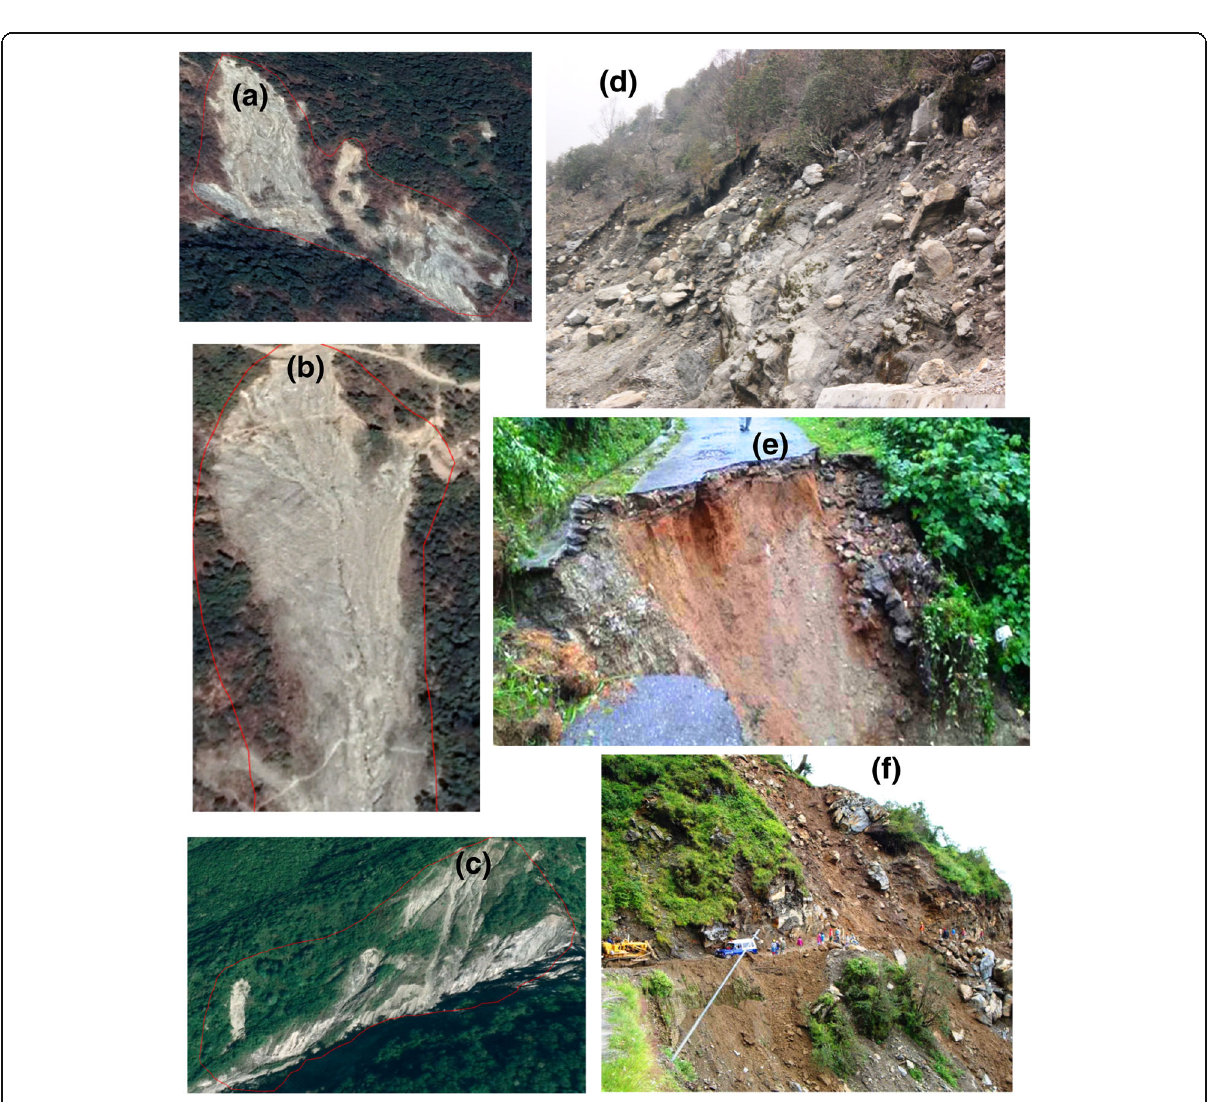
Fig. 5 Picture showing the landslide sites – from the google earth image. a Lish catchment (26°57 ′ N, 88°30 ′ 17 “ E), b Nimbong Khasmahal (26°58 ’ 04 ” N, 88°34 ′ 16 “ E), c Sittong (26°52 ’ N, 88°22 ’ 30 ” E) and from the field, d Near Kurseong town (26°55 ′ 46.32 ″ N, 88°19 ′ 50.38 ″ E), e Near Darjeeling town (26°53 ′ 13.37 ″ N, 88°17 ′ 46.45 ″ E), f Nathula road (26°54 ′ 43.14 ″ N, 88°18 ′ 21.10 ″ E)